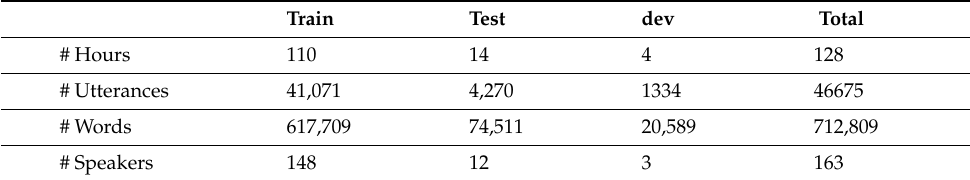
Table 10. Data specification of M2ASR-Kirghiz